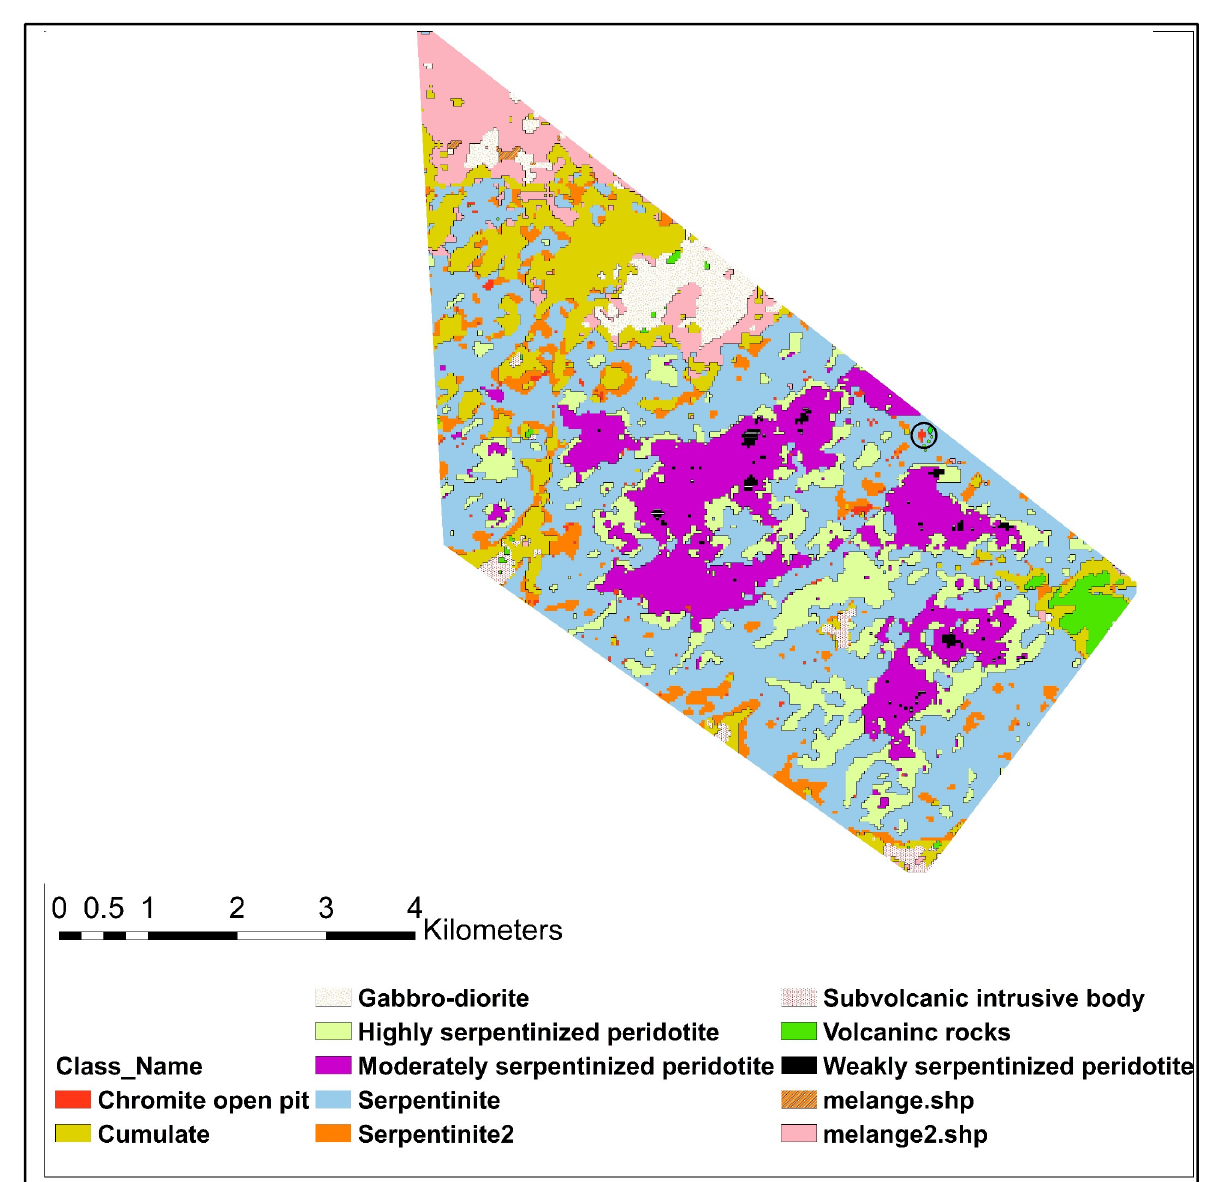
Figure 11. Resultant lithological classification image of the surveying area using the SVM method. The black circle area on the map shows one of the promising areas selected for field checking.